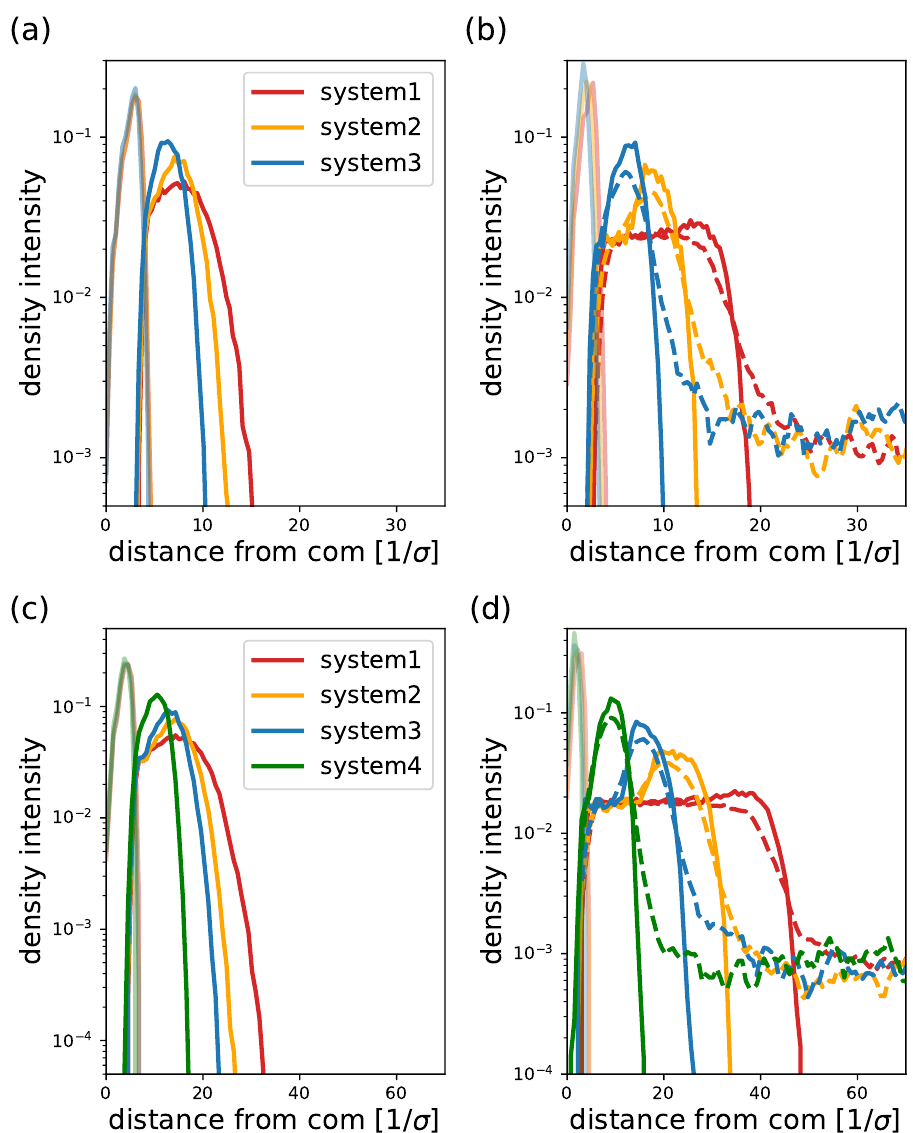
Figure 13. Density profiles for different particle/bead types. In ( a , b ), results for case 1 are plotted for neutral and charged hydrophilic blocks, respectively. In ( c , d ), results for case 2 are plotted for neutral and charged hydrophilic blocks, respectively. Hydrophobic beads are represented by lightly colored continuous lines, hydrophilic beads by colored continuous lines and counterions are represented by colored dashed lines. Other system parameters as in Figure